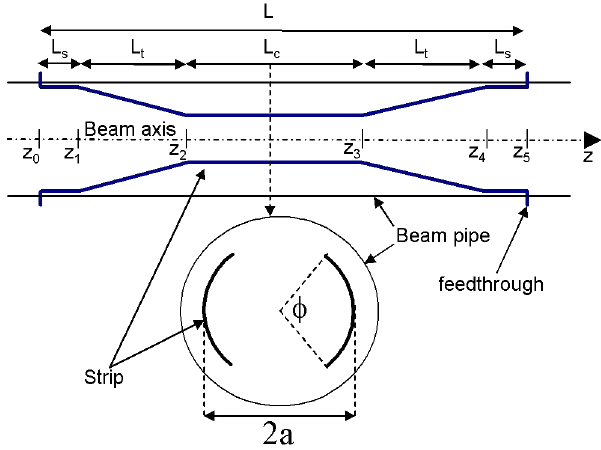
FIG. 5. Sketch of a tapered stripline kicker.